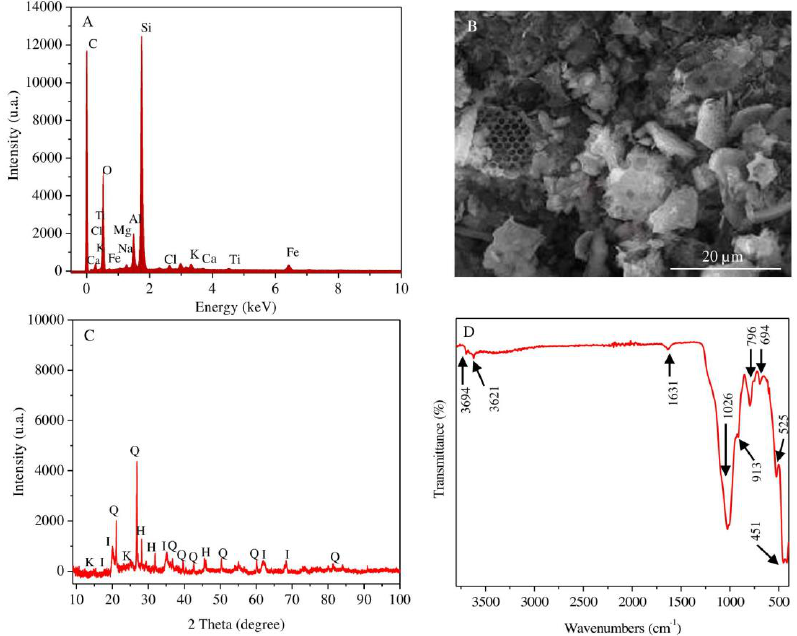
Figure 1. SEM-EDX spectrum ( A ) and SEM image ( B ); XRD patterns (I—illite; Q—quartz; K—kaolinite; H—halite) ( C ); FTIR spectrum; ( D ) curves of the studied raw diatomite samples.